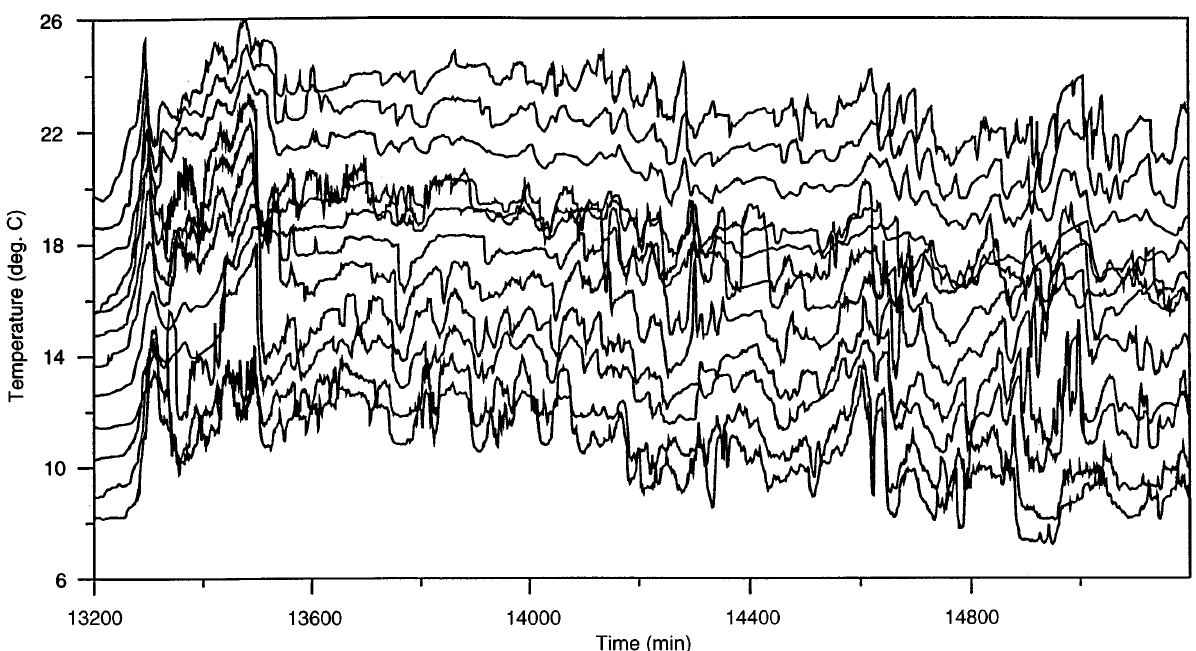
Fig. 1. Temperature recorded by the array of temperature miniloggers displaced sequentially by 1 (cid:176) C and plotted from sensor 1 ( bottom , at the west end of the array) to 12 (